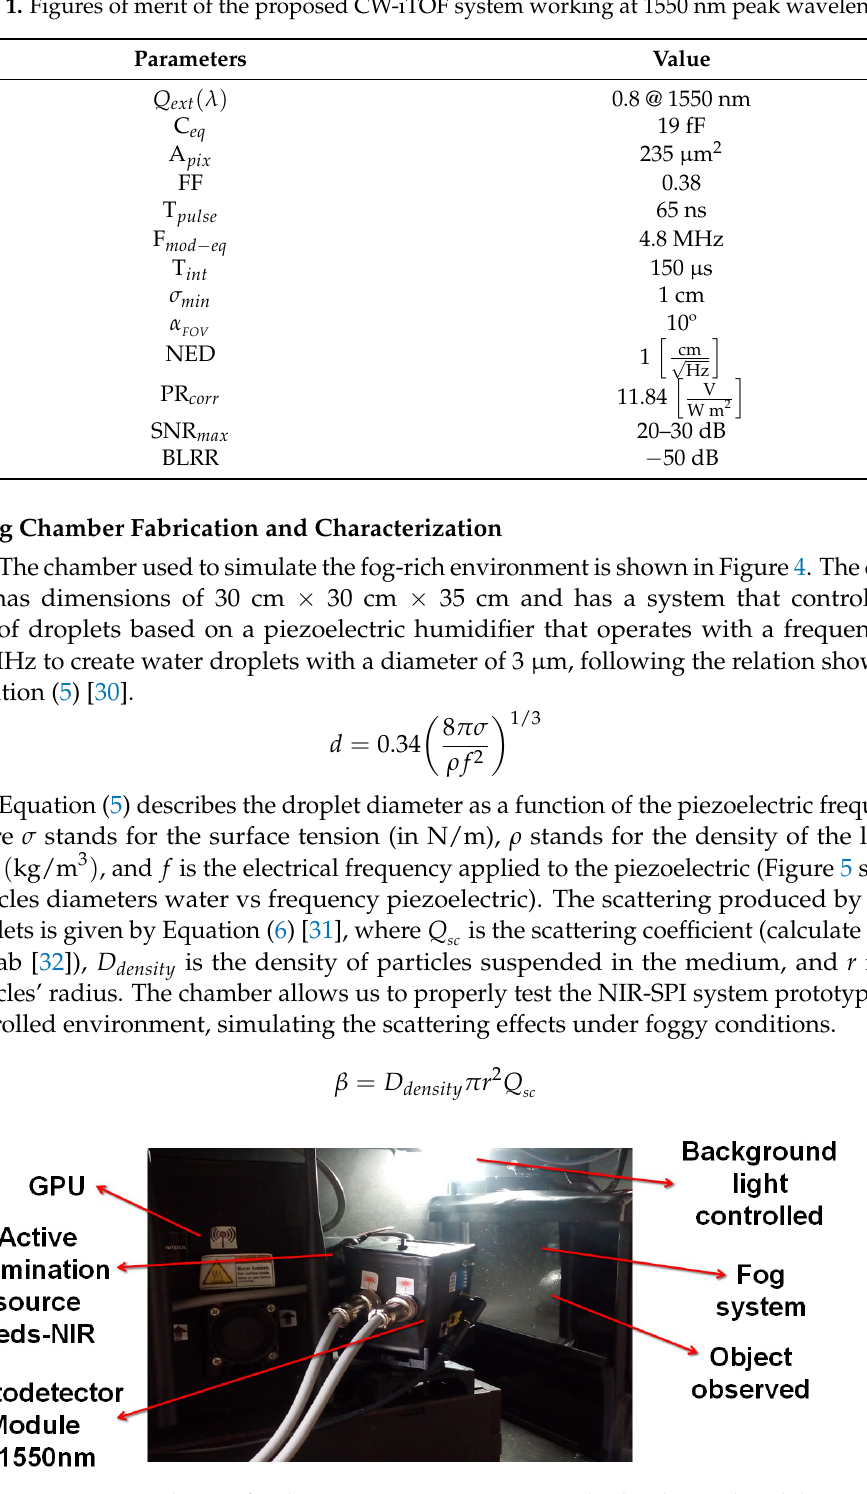
Figure 4. Experimental setup for the NIR-SPI system prototype built. The test bench has a control system to emulate fog and background illumination. The test object is placed inside the glass